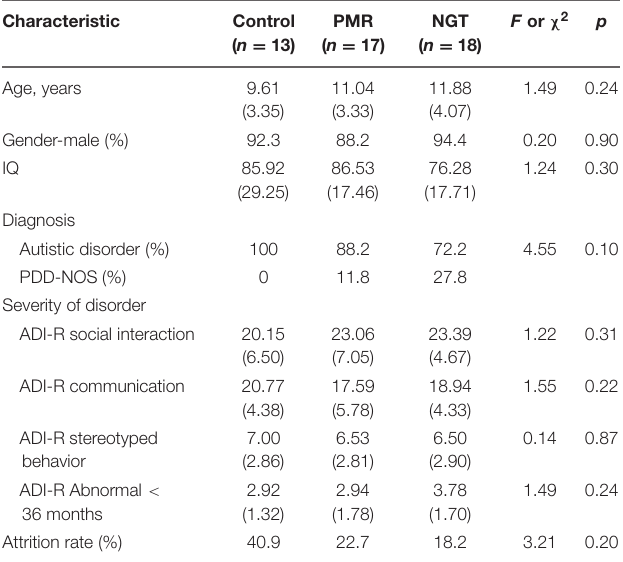
TABLE 1 | Baseline demographic and clinical characteristics of each